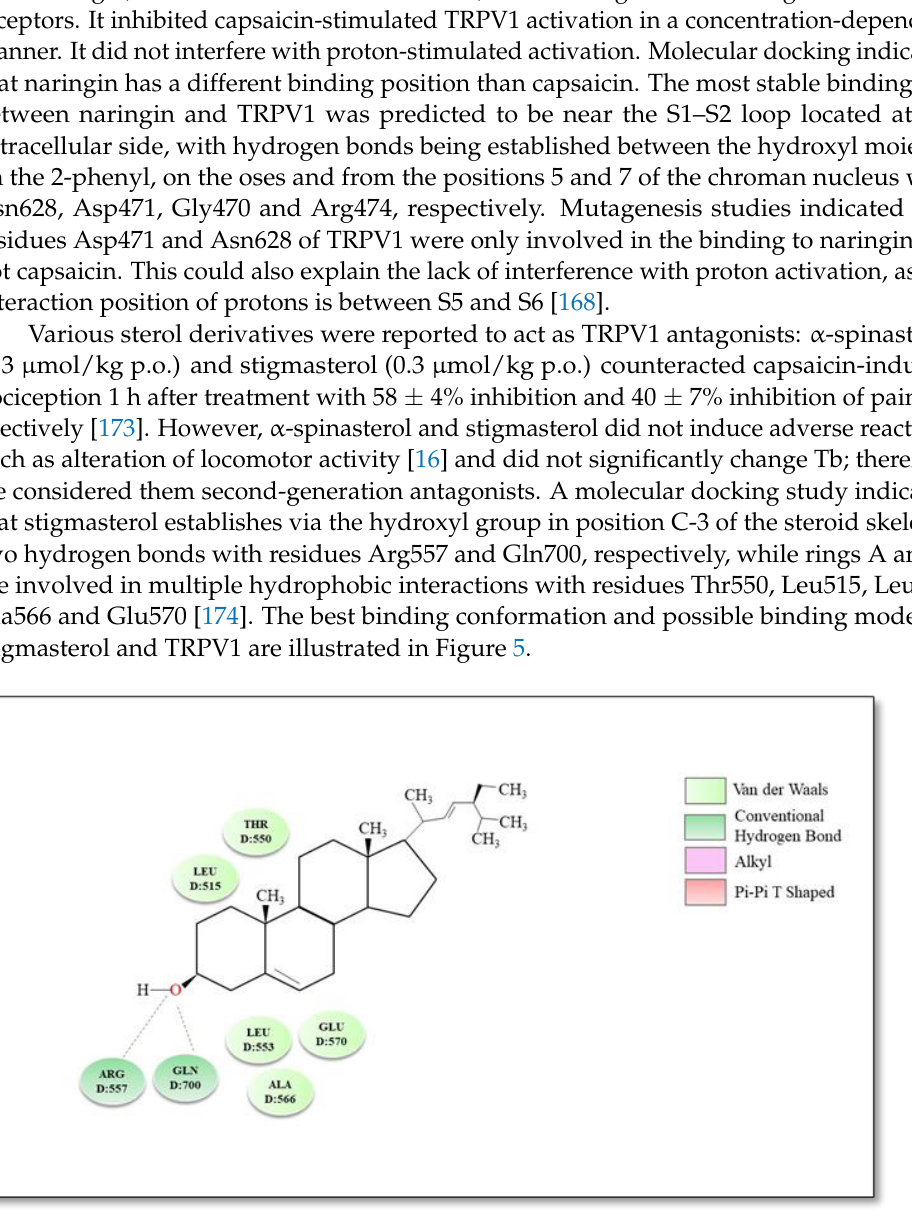
Figure 5. Molecular docking—2D diagram of stigmasterol with TRPV1 receptor. Beta- sitosterol is a sterol widely found in the vegetal world. β -Sitosterol showed analgesic effect in tail flick and hot-plate tests [175]. It was also shown to inhibit capsaicin-induced Ca 2+ influx. Molecular docking indicates it fits in the same pocket of TRPV1 receptors as capsazepine [176]. The major interactions between TRPV1/antagonists, as well as the involved amino acid residues and chemical moieties, are presented in Table 2.